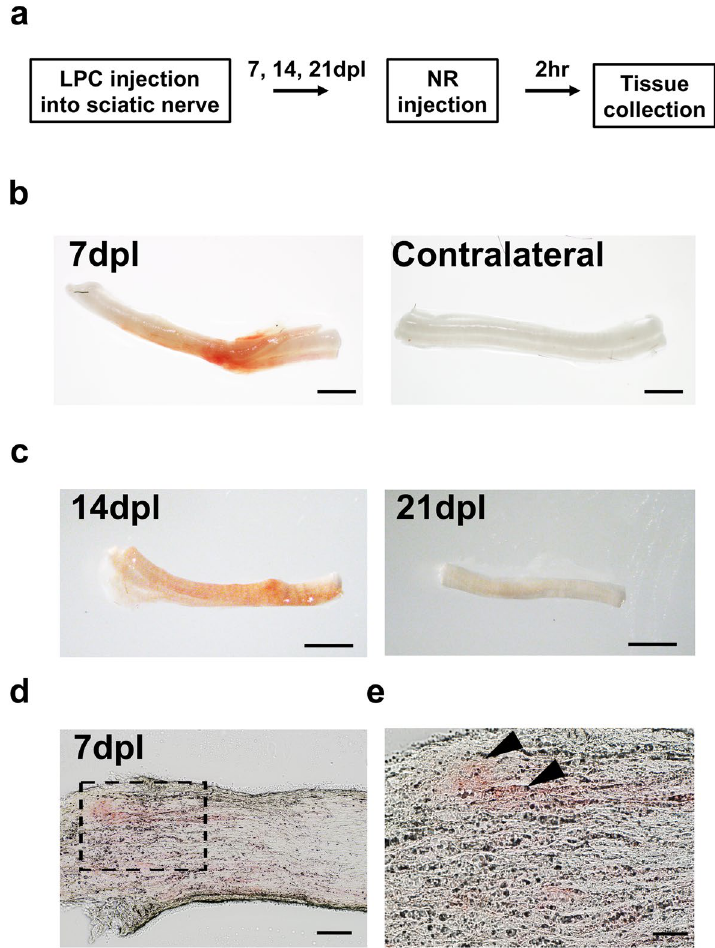
Figure 1. Demyelinated lesion in sciatic nerve identified by neutral red (NR) labeling. ( a ) Experimental design of a sciatic nerve lesion induced by lysophosphatidylcholine (LPC) injection and labeled with NR which was injected 2 h before sacrifice at 7–21 days post lesion (dpl). ( b ) Representative pictures of ipsilateral sciatic nerve with NR labeling and contralateral unlabled nonlesion sciatic nerve at 7 dpl (n = 5 mice per timepoint examined). Scale bar, 1 mm. ( c ) Representative pictures of ipsilateral sciatic nerve with NR labeling at 14 and 21 dpl (n = 3 mice per timepoint examined). Scale bar, 1 mm. ( d ) Longitudinally sectioned nerve showing NR positive areas at 7 dpl. ( e ) Enlarged image of ( d ) (black dotted square). ( b – e ) left and right sides of images are proximal and distal sides, respectively. Scale bar, 100 µm ( d ), 50 µm ( e